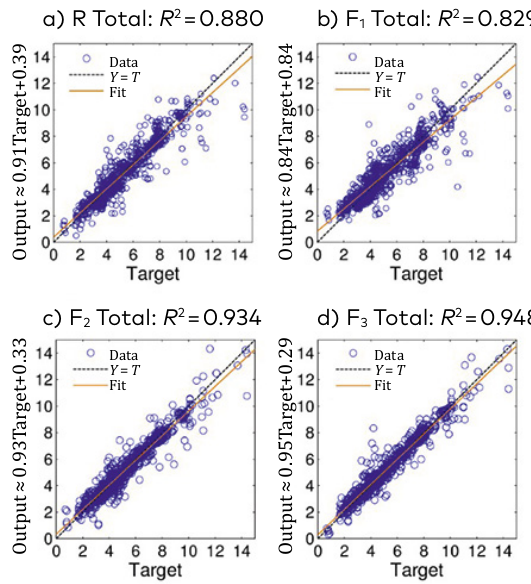
Figure 5. Regression charts for R, F 1 , F 2 , and F